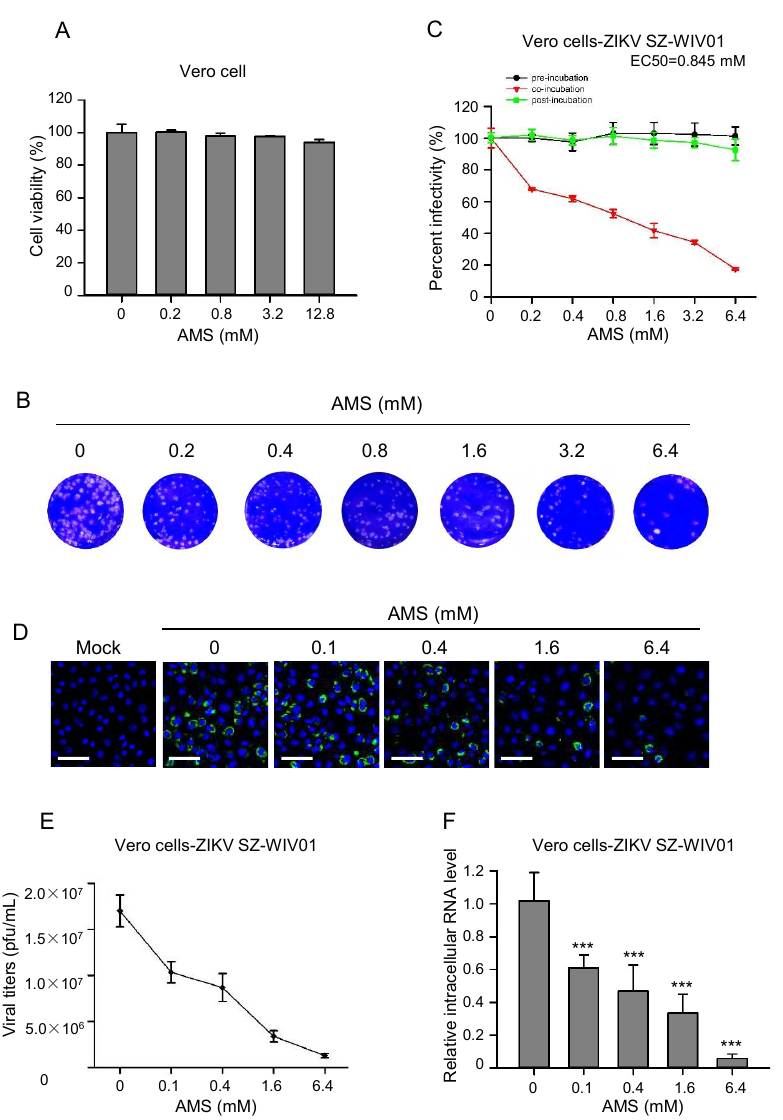
Figure 7. AMS affected ZIKV entry process in Vero cells. ( A ) AMS cytotoxicity was assessed by the viability of Vero cells treated with AMS. Pre-seeded Vero cells were treated with increasing concentrations of AMS for 24 h, and then subjected to cell viability analysis using CCK-8. ( B , C ) AMS affected ZIKV infection in Vero cells at early stage. Vero cells were treated with indicated concentrations of AMS at different time points prior, during, or after the addition of ZIKV strain SZ-WIV01 (100 pfu) and the inhibition efficiency was measured with plaque assay. The plaques of Vero cells treated with AMS during the addition of ZIKV strain SZ-WIV01 ( B ). Plaques were counted and percentage of plaque reduction was calculated ( C ). ( D – F ) AMS affected ZIKV strain SZ-WIV01 replication in Vero cells in a dose-dependent manner. ZIKV strain SZ-WIV01 was incubated with indicated concentrations of AMS and infected Vero cells at an MOI of 0.1. At 48 h p.i., the intracellular level of ZIKV E protein (green) in Vero cells was detected with immunofluorescence analysis ( D ). The titer of ZIKV in the supernatant was quantified by plaque assay ( E ). The intracellular level of ZIKV RNA was quantified with quantitative PCR ( F ). Bars, 50 µ m. Data are means ± SD of triplicate experiments. *** p <